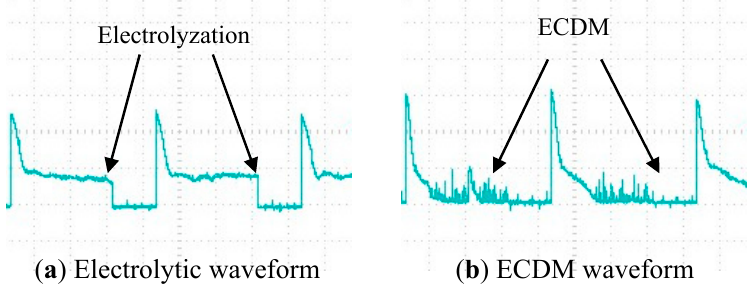
Figure 3. Current waveform from electrolytic jump to ECDM.